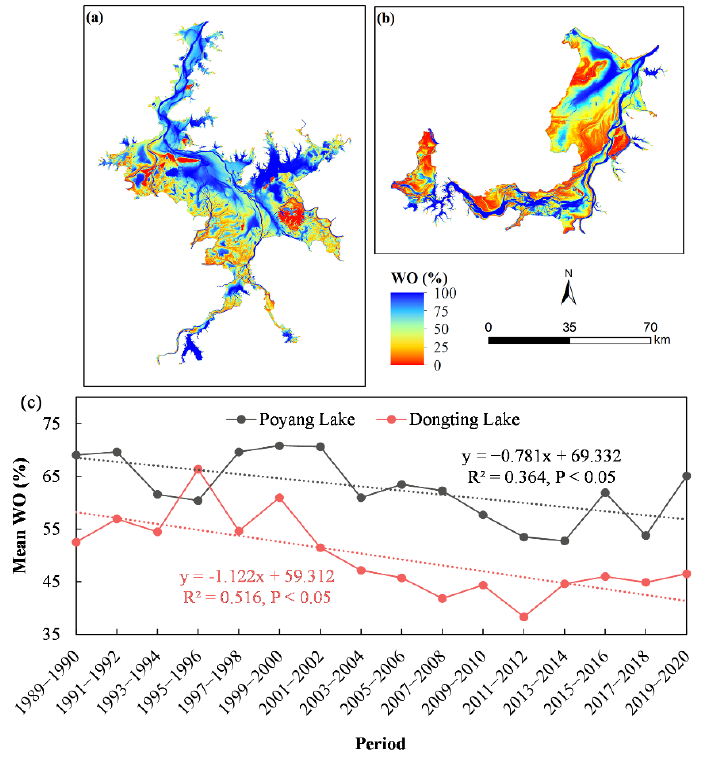
Figure 5. Spatial pattern of and temporal changes in water occurrence in Poyang Lake and Dongting Lake from 1989 to 2020. ( a , b ) indicate the spatial patterns of Poyang Lake and Dongting Lake, respectively. ( c ) indicates the temporal changes in the mean WO in Poyang Lake and Dongting Lake from 1989 to 2020.